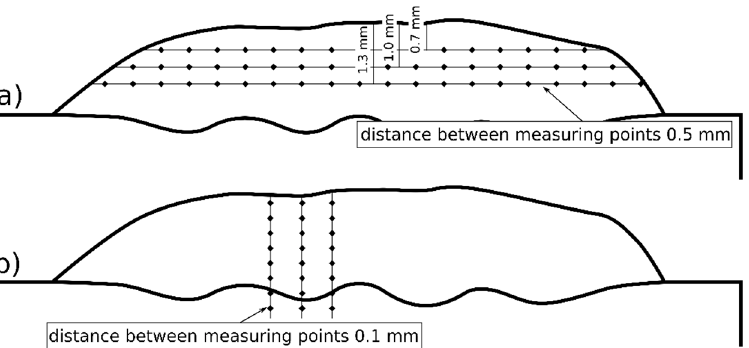
Figure 1. Schematic diagram of Vickers microhardness measurement lines: ( a ) measurements across the beads and ( b ) measurements from the surface to the base material. the beads and ( b ) measurements from the surface to the base